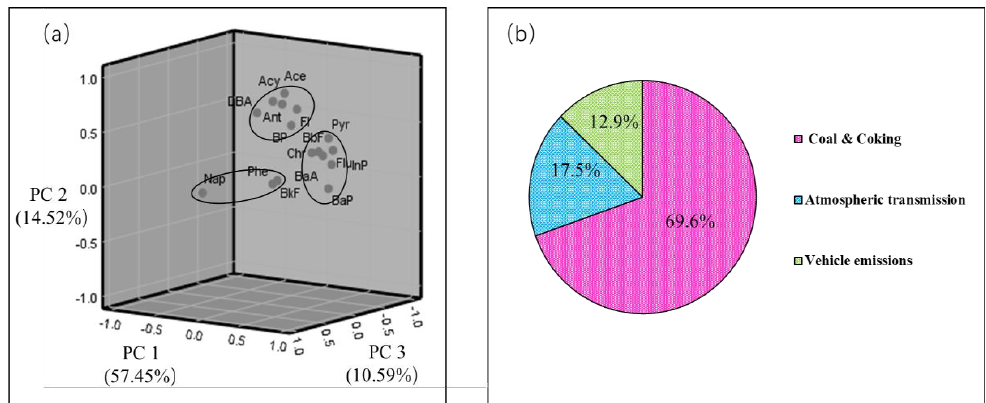
Figure 5. ( a ) Factor loadings and ( b ) the contributions of the three major sources of PAHs in surface soil samples.